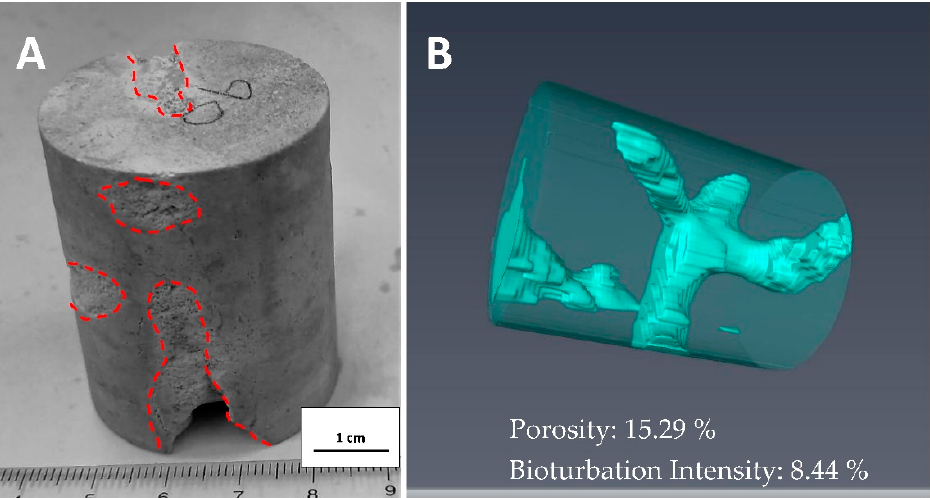
Figure 2. Bioturbation estimation using CT scan. ( A ) Plug photo showing the Thalassinoides burrow highlighted by a dotted red line. ( B ) 3D CT scan view of the studied sample showing the bioturbation network within the plug.